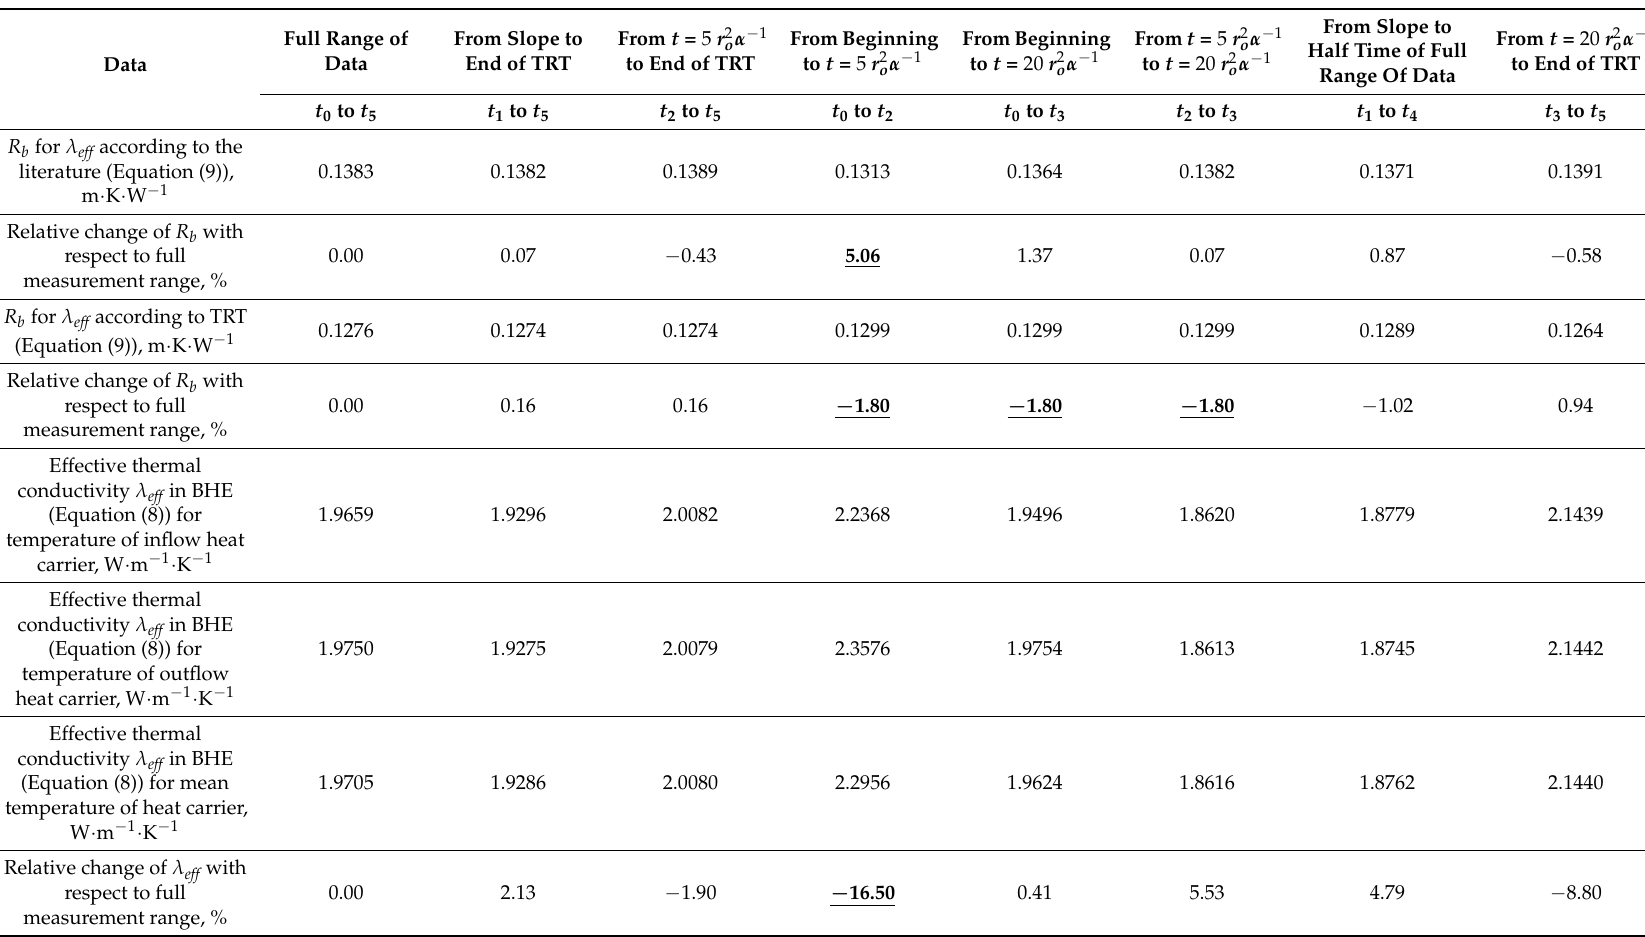
Table 5. Thermal resistivity R b and effective thermal conductivity λ eff of BHE, as determined for various data intervals (TRT at Laboratory of